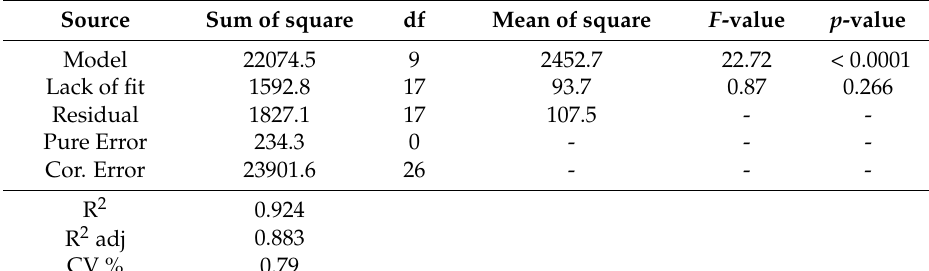
Table 4. ANOVA of the predicted model for USAE of RA from freeze-dried P. scutellarioides leaves.